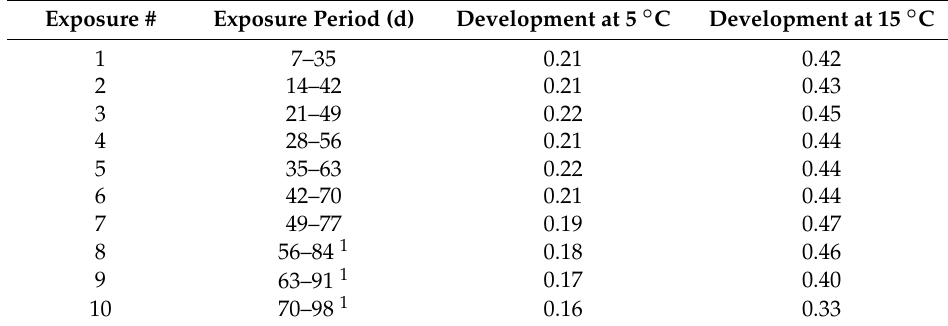
Table 2. Estimated proportion of total development that occurred during the exposures to experimental d TC temperatures ( = 1 − ; as described for Equation D TC